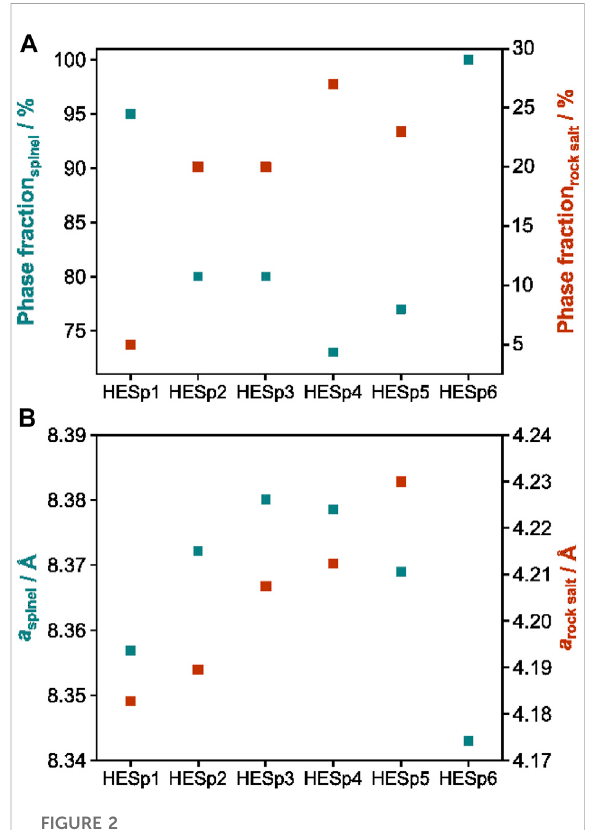
FIGURE 2 (A) Phase fractions and (B) a -axis length of the spinel phase (green) and rock-salt phase